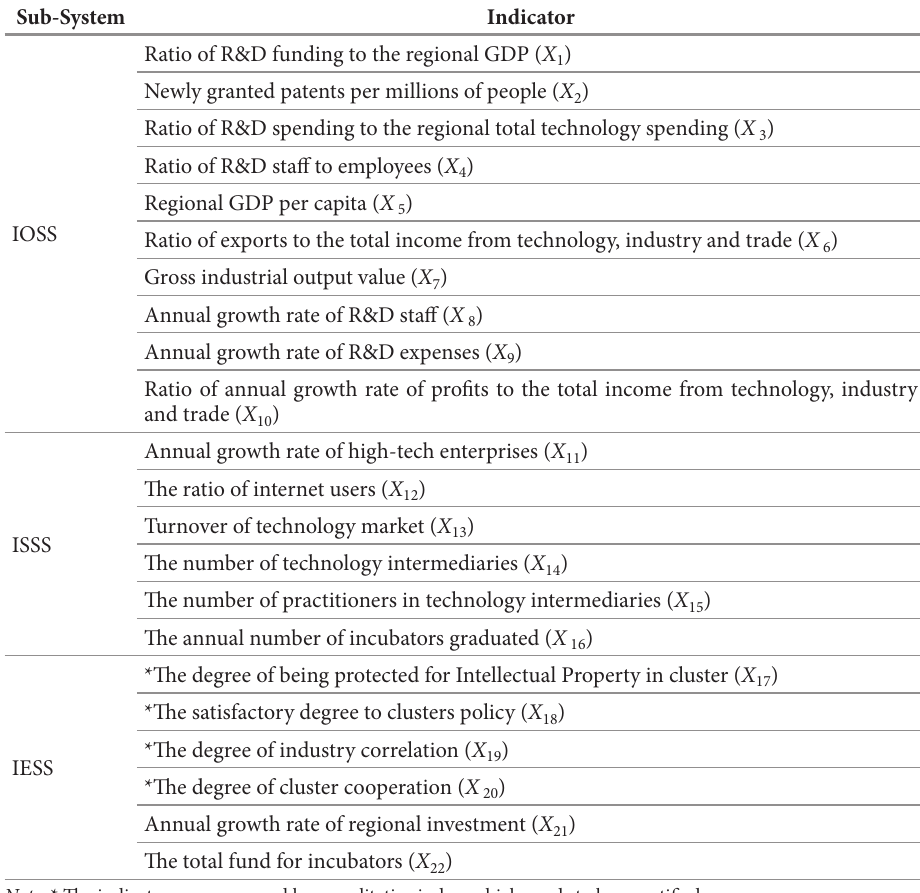
Table 2. Indicators for evaluating Innovation Capability for Science Parks